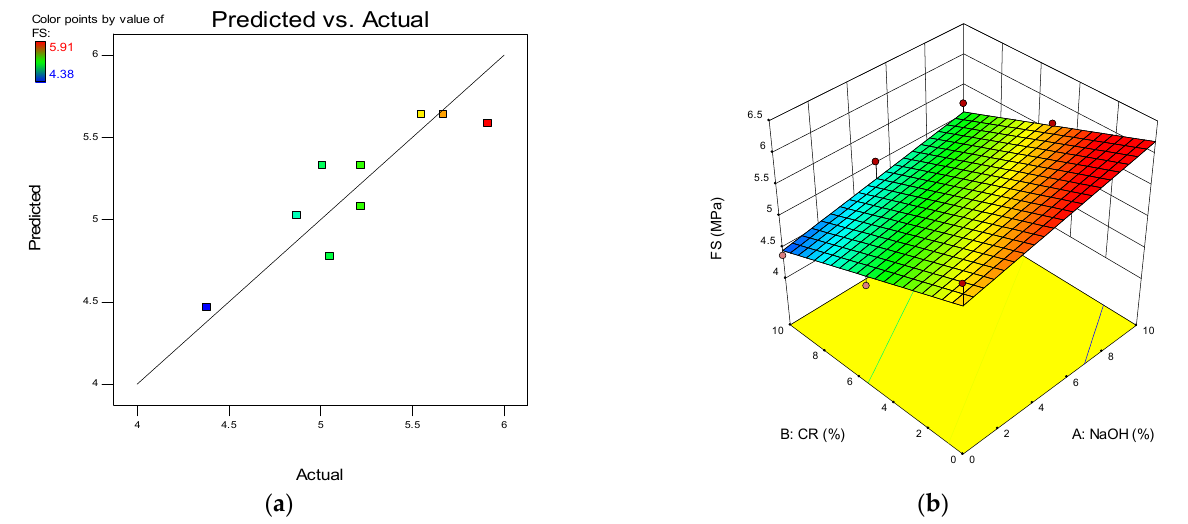
Figure 13. ( a ) Predicted vs. actual plot for flexural strength (FS). ( b ) 3D response surface diagram for FS.